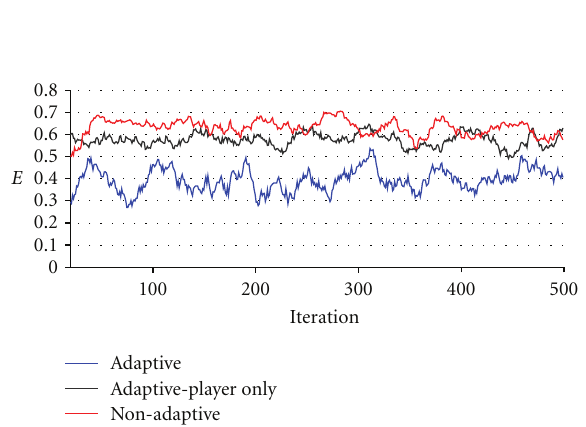
Figure 6: E ff ectiveness test results for the fundamental TAP experiments: plots of E against the number of iterations. Lower E means better performance. A single point on the graph represents a full game episode. The red-colored line at the top depicts the results with nonadaptive agents, the black line below shows the results with agents adaptive only towards the PC, and the blue line at the bottom shows the results with agents adaptive to all other